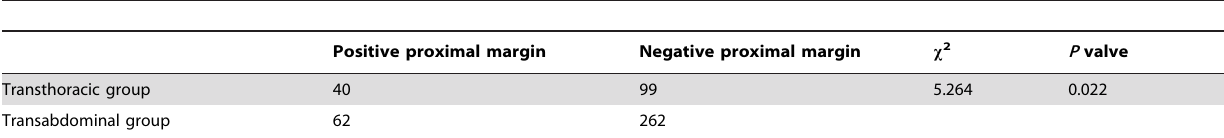
Table 4. Incidence of positive proximal margin between transthoracic group and transabdominal group in terms of Type II and III